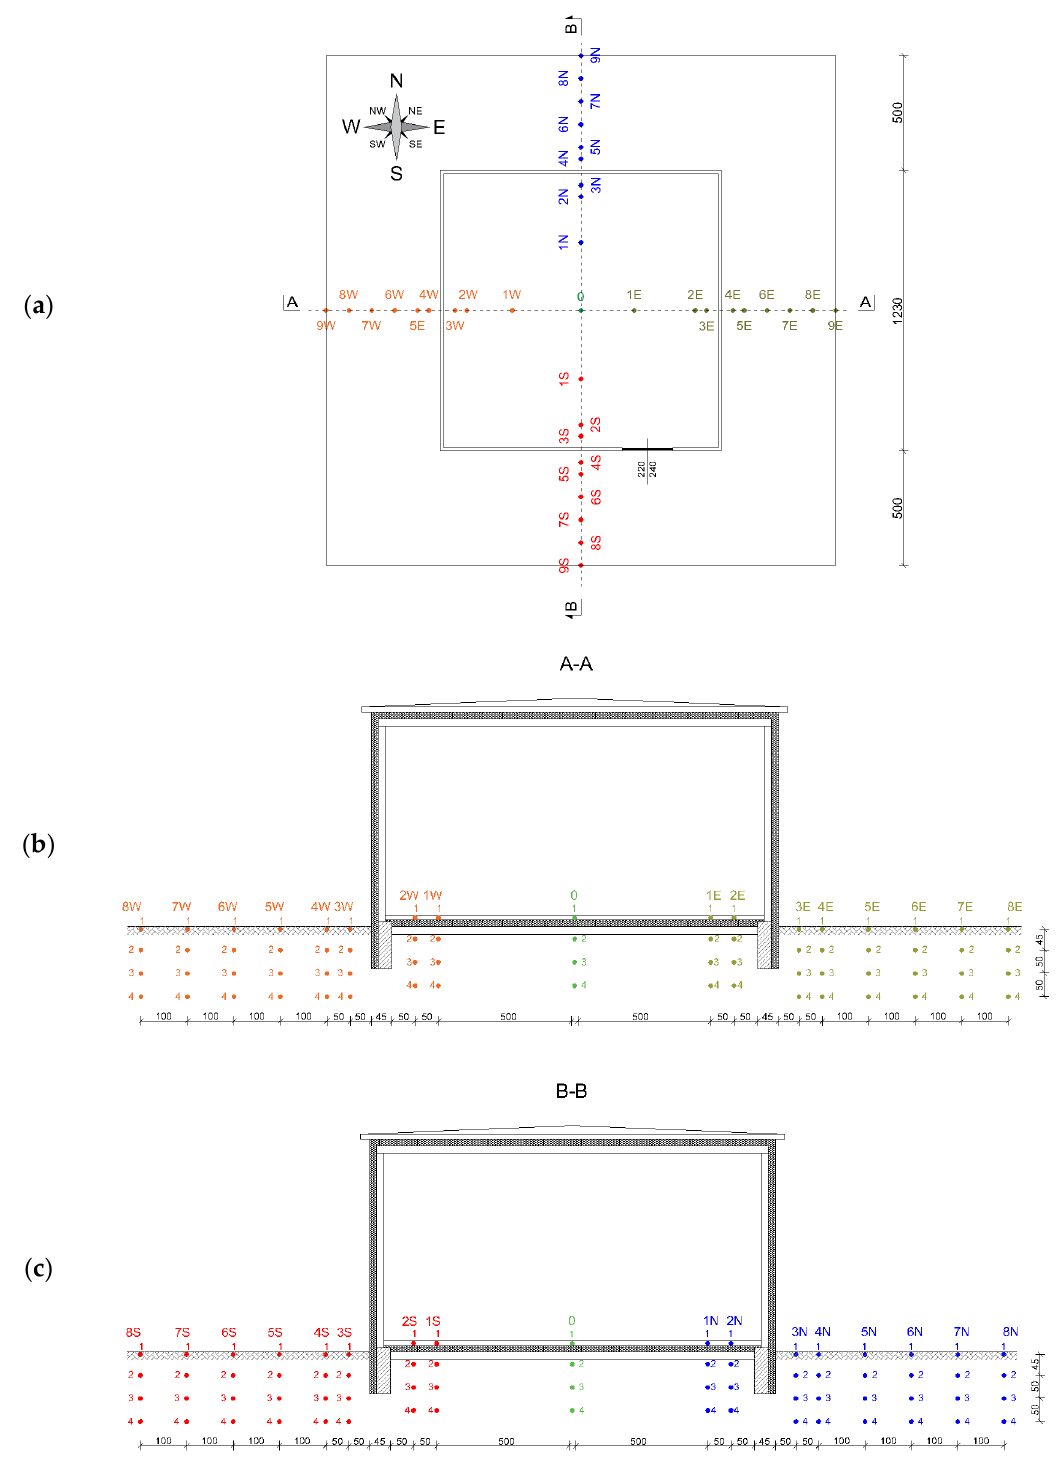
Figure 2. Distribution of the measurement points of the floor and ground temperature: ( a ) projection, ( b ) cross ‐ section A ‐ A, ( c ) cross ‐ section B ‐ B. The calculation procedure performed in this work is shown in Figure 3.